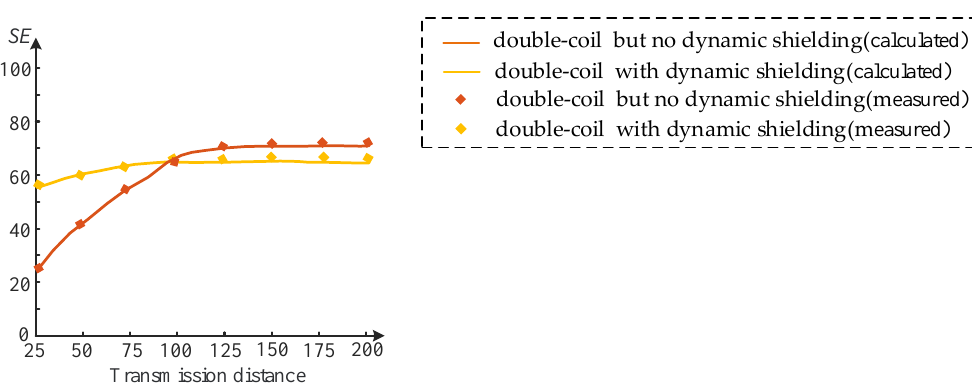
Figure 16. SE for different transmission distances with and without dynamic shielding scheme. To further confirm the feasibility of this dynamic shielding scheme, the power trans- mission efficiency η of the WPT system is investigated. Figure 17 shows the variation curves of η at different transmission distances, where blue denotes no shielding and yellow denotes double-coil active shielding. It is clear that, although slightly fluctuating, the measured values match well with the calculated values. The η with double-coil active shielding is slightly reduced compared with that with no shielding, but the reduction is not significant and is approximately 3.1%. It is related to the introduction of the shielding sys- tem. It can be found that the addition of this double-coil active shielding structure achieves good shielding effectiveness against EMF leakage at the same time, without causing a significant sacrifice in power transmission efficiency. This means that the application of the double-coil dynamic shielding scheme can not only avoid the waste of power but also reduce the degrading influence of the shielding device on the transmission performance of the WPT system; thus, its feasibility is verified.